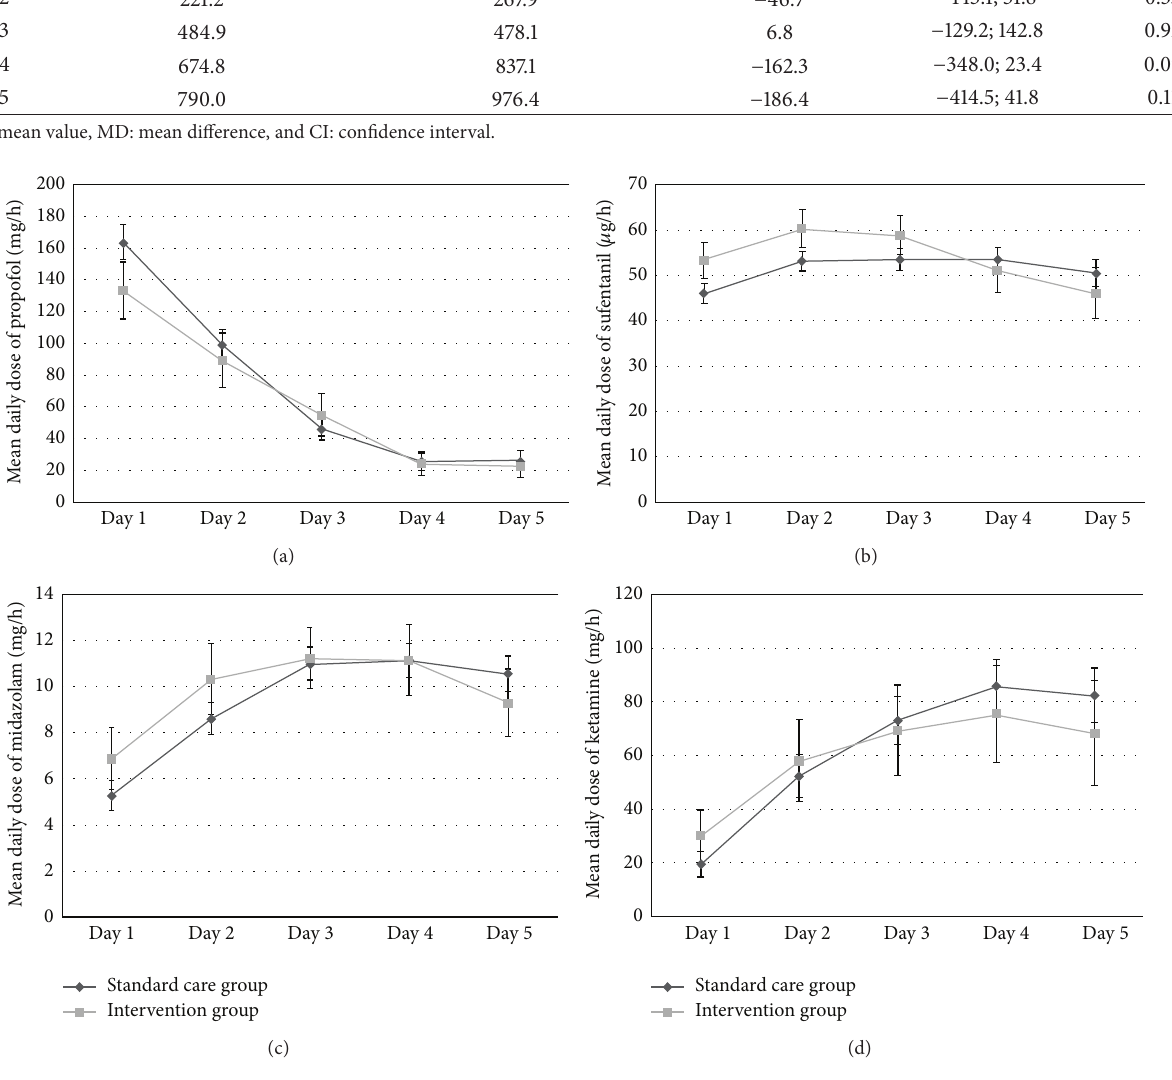
Figure 1: No significant differences in the mean daily dose between the standard care and the intervention group were seen for propofol, sufentanil, midazolam, and